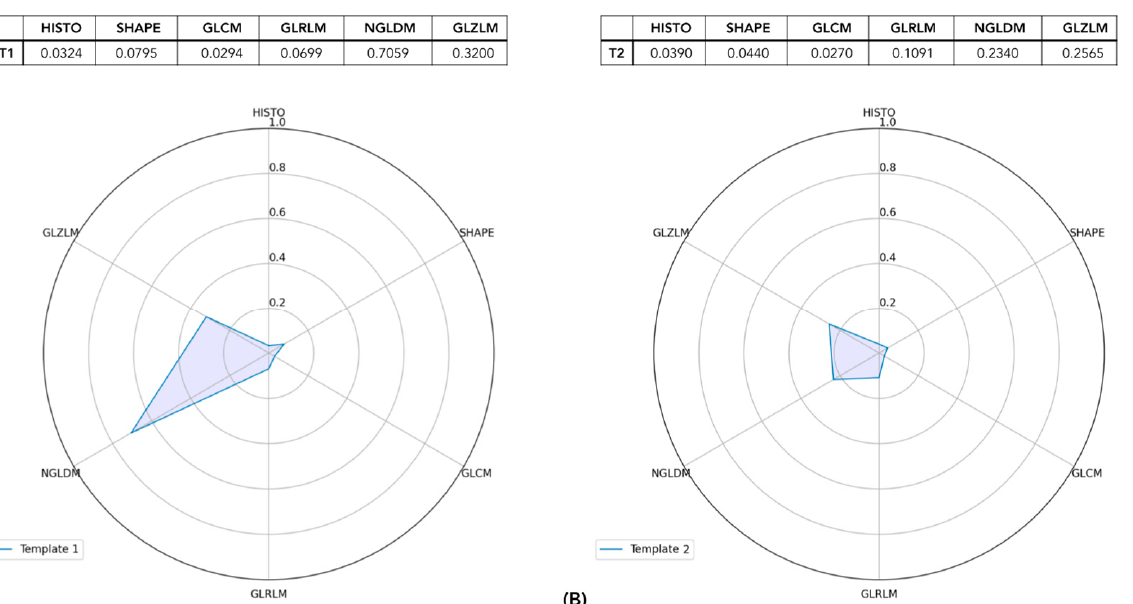
Table 2. Clusters of lesions as grouped by mini-batch k-means clustering were characterized in terms of TLA, SUV, site, and GLCM entropy and results are displayed ( p -values).